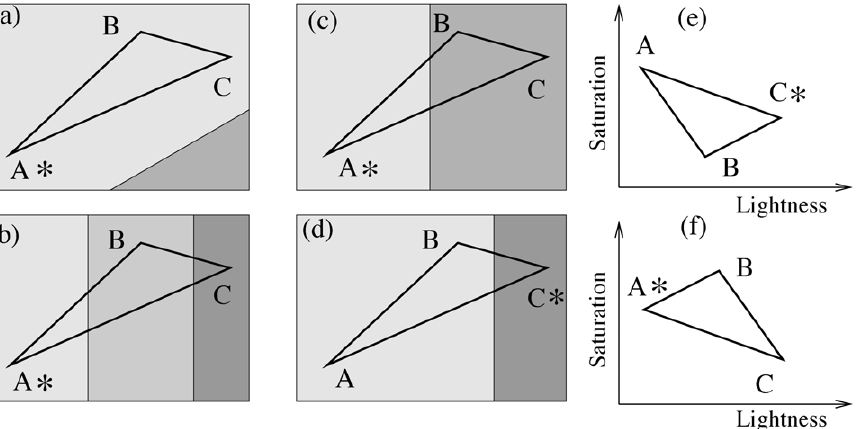
Figure 1. The category (a–d) and lightness-saturation (e,f) biases in triad choices. (a–d): A triad (A,B,C) is represented as a triangle in a CIE space. In the absence of categorical and other biases, stimulus A is the most likely choice. In the presence of categorical biases, the choice might shift. Different categories are denoted by different background shades, and the most likely choice is marked by a star. (a) All stimuli belong to the same category; A remains the most likely choice. (b) All three stimuli belong to different categories; the choice remains A.(c) Stimulus A belongs to a different category than B and C; the choice remains A. (d) Stimulus C belongs to a different category from A and B; the choice might shift from A to C. (e,f): The same triad projected into the lightness-saturation space (a schematic). (e) Stimulus A is the darkest and most saturated color; the choice might shift from A to C. (f) Stimulus A is not simultaneously the darkest and most saturated color; the choice remains A